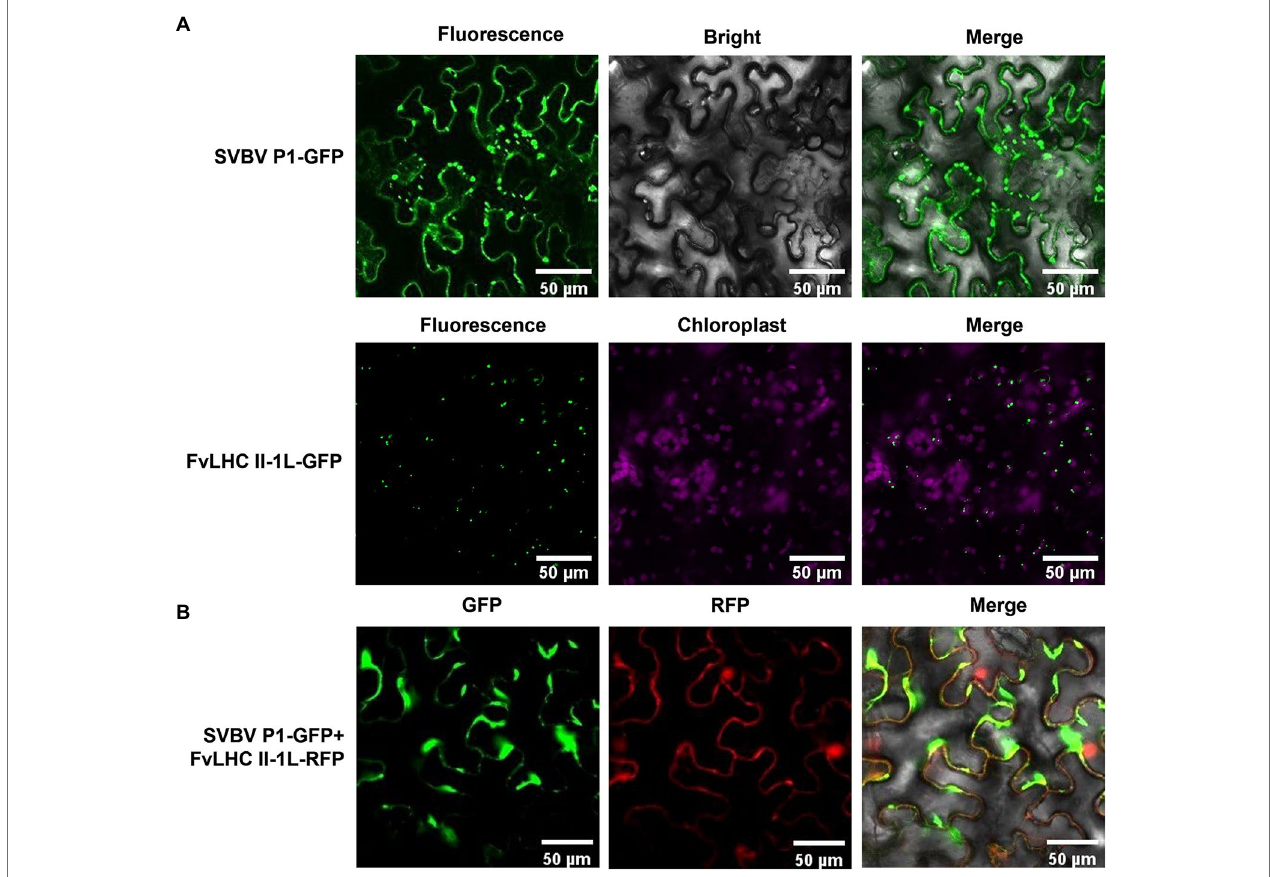
FIGURE 2 | Subcellular localization of SVBV P1 and FvLHC II-1L. (A) Subcellular localization of SVBV P1 and FvLHC II-1L in N. benthamiana leaves. N. benthamiana leaves were infiltrated with the indicated vector combinations. Green fluorescent protein (GFP) was observed at 3 dpi. (B) The co-localization of